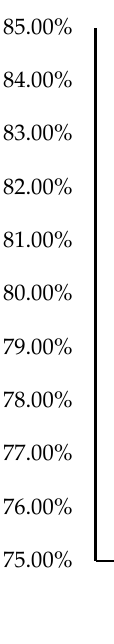
Figure 3. Changes in the mean value of the similarity of risk factor types of the fintech industry from 2015 to 2019.